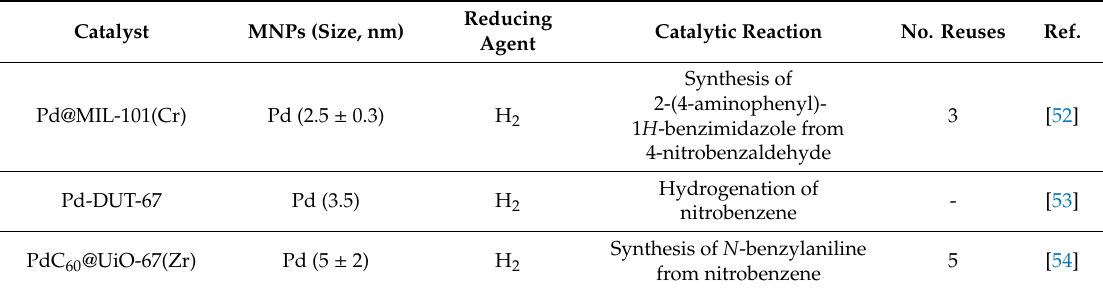
Table 1. List of various MNPs@MOFs used as heterogeneous solid catalysts for reduction of